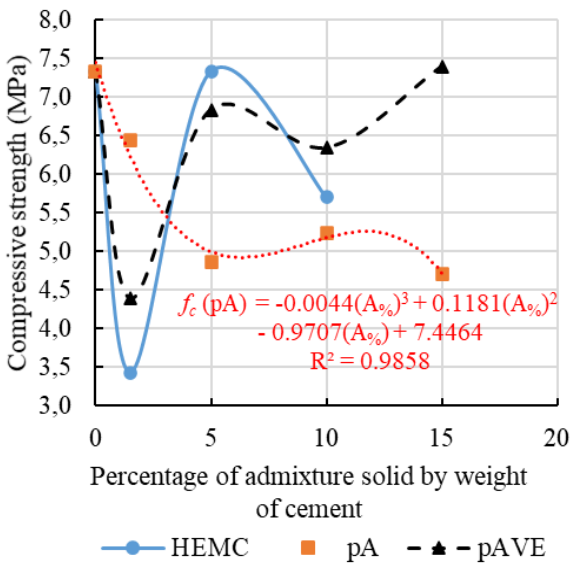
Figure 10. Compressive strength